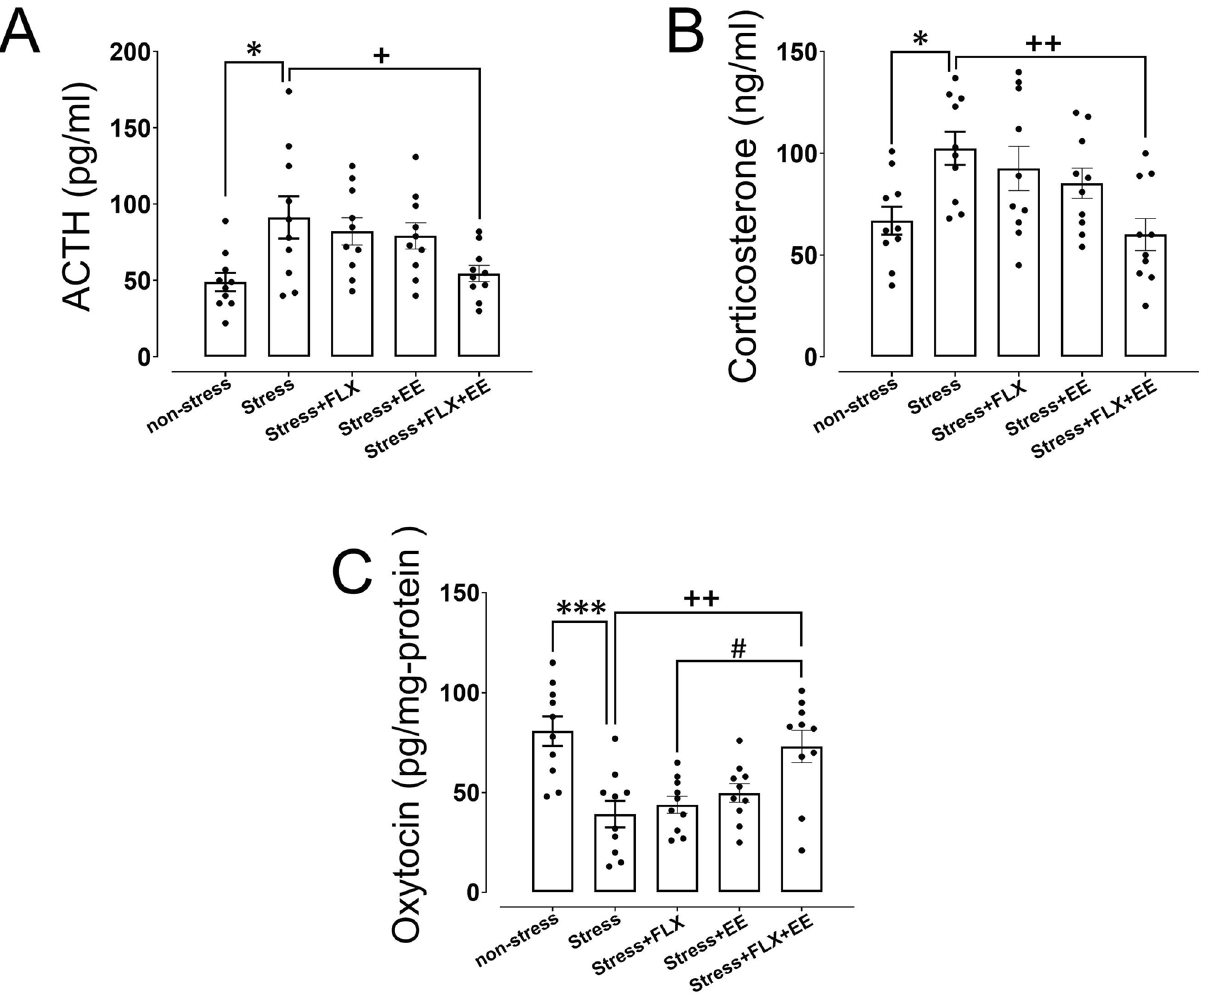
Figure 2. The effects of gestational stress, fluoxetine (FLX) treatment and environmental enrichment (EE) on ACTH (A) and corticosterone (B) in the serum, and oxytocin levels in the brain (C) during the postpartum period in dams. Values are presented as mean ± SEM (N = 10). Significant differences: * P < 0.05 and *** P < 0.001, compared to non-stress group; + P < 0.05 and + + P < 0.01, compared to stress group; # P < 0.05, compared to stress + FLX